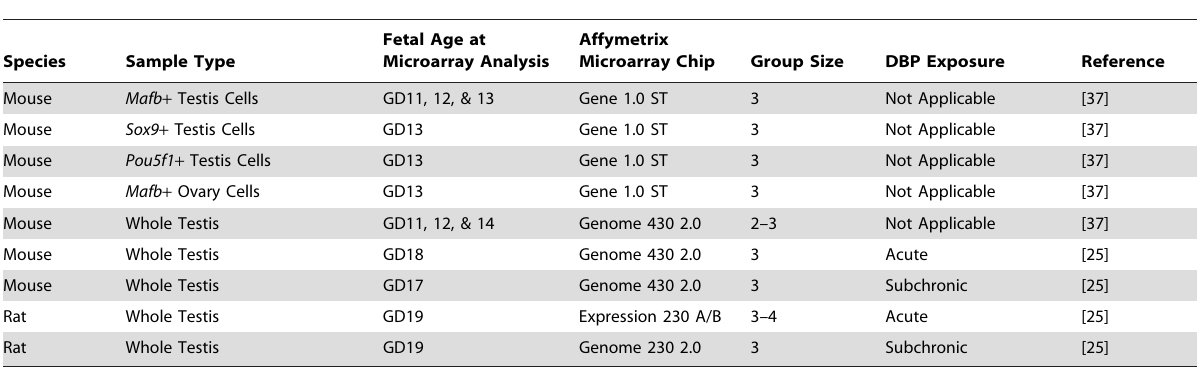
Table 1. Microarray datasets used to obtain fetal Leydig cell candidate